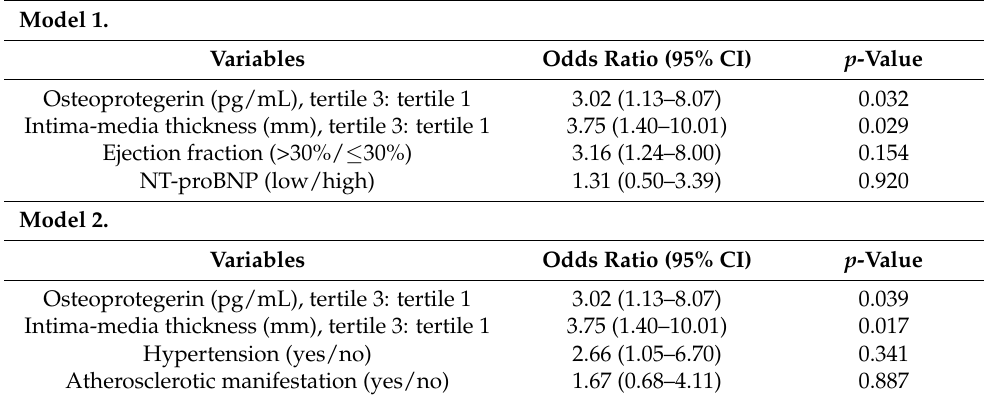
Table 4. Multiple logistic regression analysis of the factors that were correlated with arterial stiffness (PWV) in the overall patient group ( n =